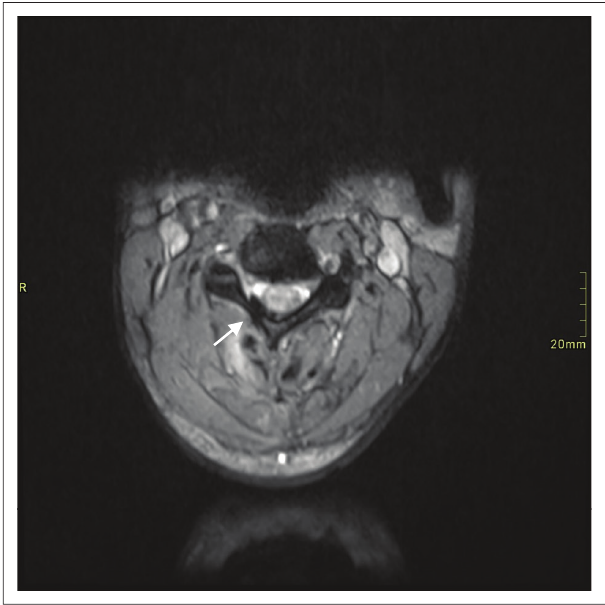
FIGURE 1: Axial gradient recalled echo image demonstrating subdural haemorrhage (arrow).